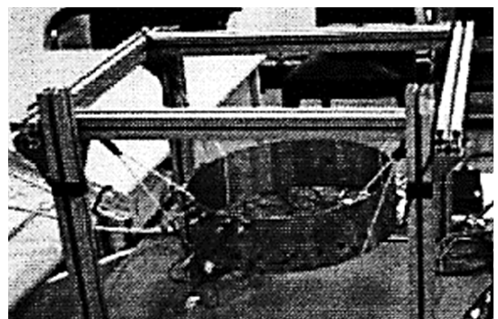
Figure 1. Three-layer cylindrical shell specimen.